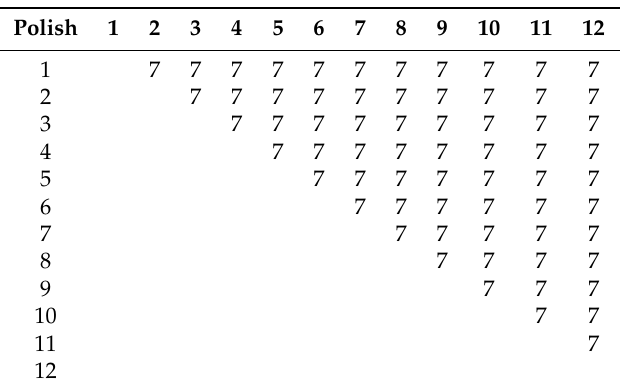
Table 3. An example demands